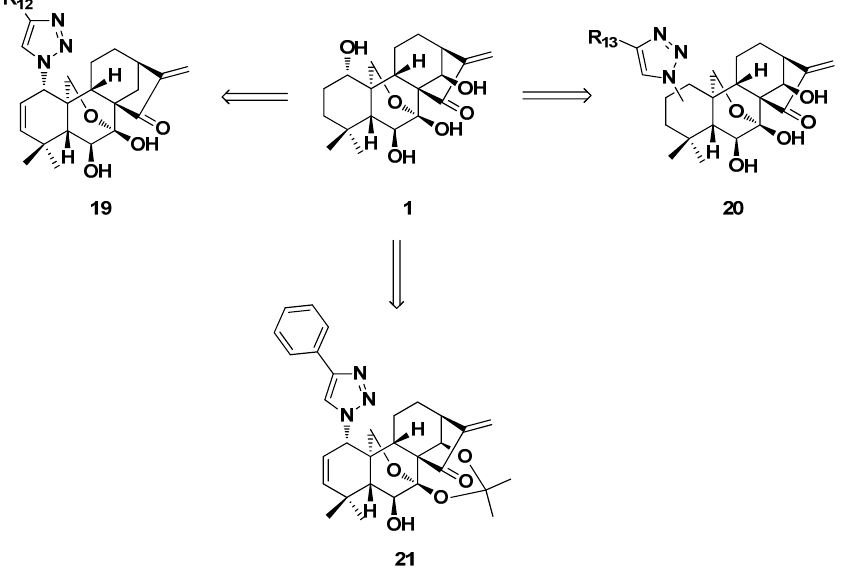
Figure 10. Installation of azides and 1,2,3-triazole at the C-1, -2, or -3 position derivatives ( 19 – 21 ) of oridonin.